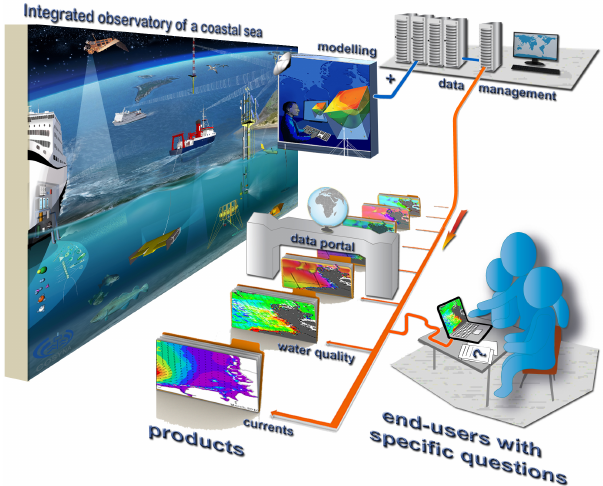
Figure 1. The integrated COSYNA approach: combination of ob- servations and numerical modelling, data management, and stake- holder interactions (COSYNA presentation;